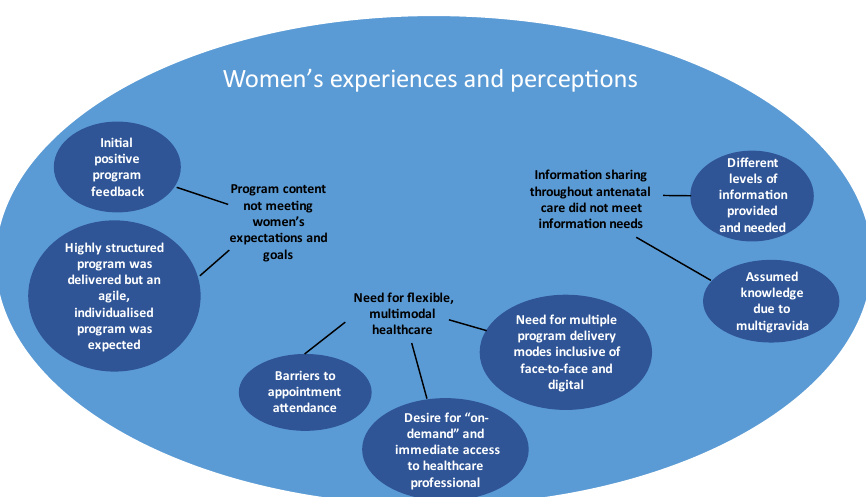
Figure 2. Themes and sub-themes relating to women’s experiences and perceptions of the LWdP program and antenatal care.